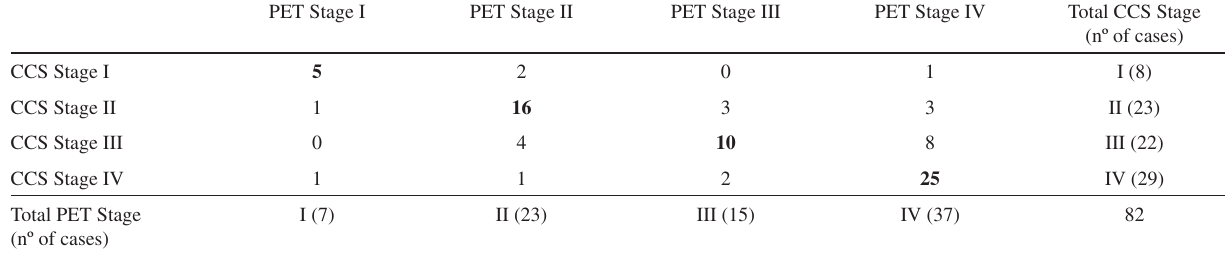
Table 5 - Initial staging distribution for Conventional Clinical Staging (CCS) and FDG-PET according to the Ann Arbor staging system and the corresponding up- and down-staging PET Stage I